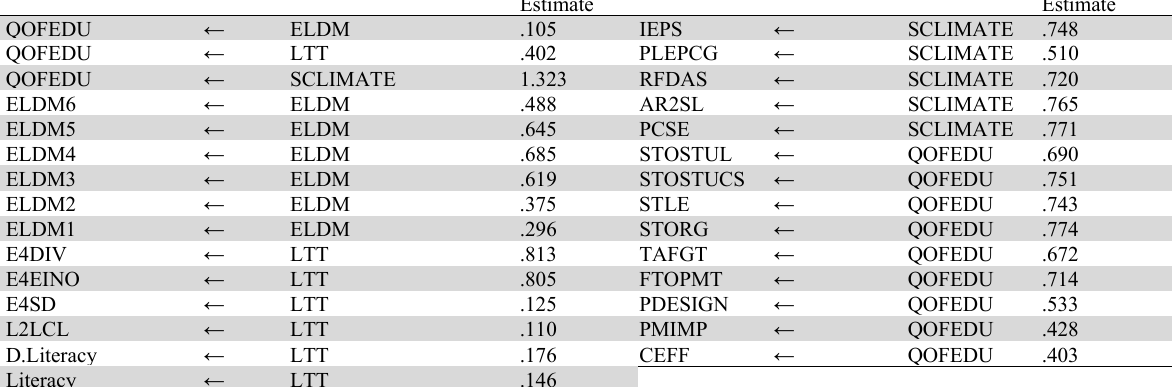
Standardized Regression Weights: (Group number 1 - Default model)